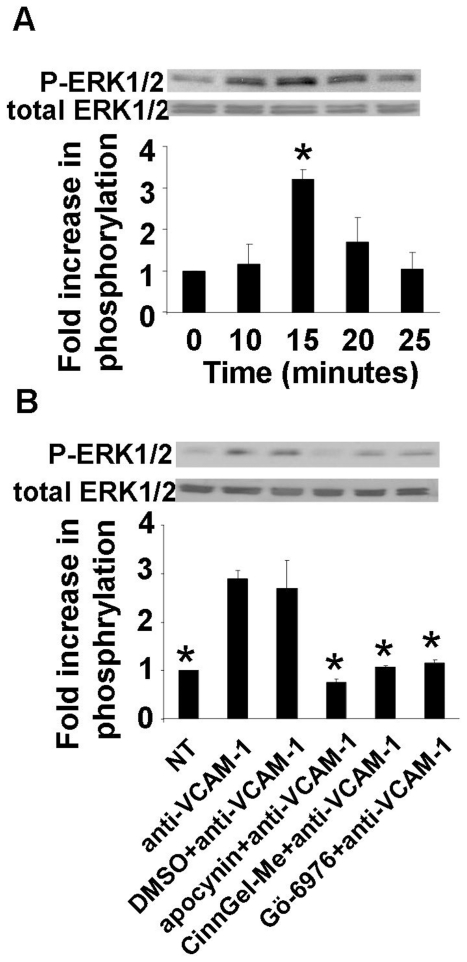
Mechanisms for VCAM-1 activation of ERK1/2 in HMVEC-L.Treatment of HMVEC-L cells overnight with 10ng/ml TNF-α induced VCAM-1 expression (data not shown). A) Confluent monolayers of TNF-α-treated HMVEC-Ls were nontreated (NT) or treated with 27 µg/ml anti-VCAM-1 plus 15 µg/ml of a secondary antibody to crosslink and stimulate VCAM-1. Phosphorylation of ERK1/2 Thr202/Tyr204 (P-ERK1/2) and total expression of ERK1/2 was examined by western blot using rabbit anti-phospho ERK1/2 Thr202/Tyr204 (1/1000) followed by HRP-conjugated anti-rabbit (1/2000) and ECL detection. B) Confluent monolayers of TNF-α stimulated HMVEC-L cells in 12 well plates were nontreated or incubated for 30 minutes with the solvent control DMSO, apocynin (4 mM), Gö-6976 (2.3 nM) or CinnGEL 2-methylester (10 µM). These endothelial cells were then stimulated with anti-VCAM-1 antibody plus a secondary antibody for 15 minutes. The apocynin, DMSO, Gö-6976 or CinnGEL 2-methylester had no effect on endothelial cell viability as determined by trypan blue exclusion and had no effect on VCAM-1 expression as determined by flow cytometry (data not shown). Representative western blots are shown. Data presented are the mean ± standard deviation from 3 experiments. The phosphorylation status of ERK1/2 is presented as the fold increase in the ratio of the relative intensity of P-ERK1/2 divided by the relative intensity of the loading control (total ERK1/2). *, p<0.05 compared to A) NT cells or B) anti-VCAM-1 stimulated cells.